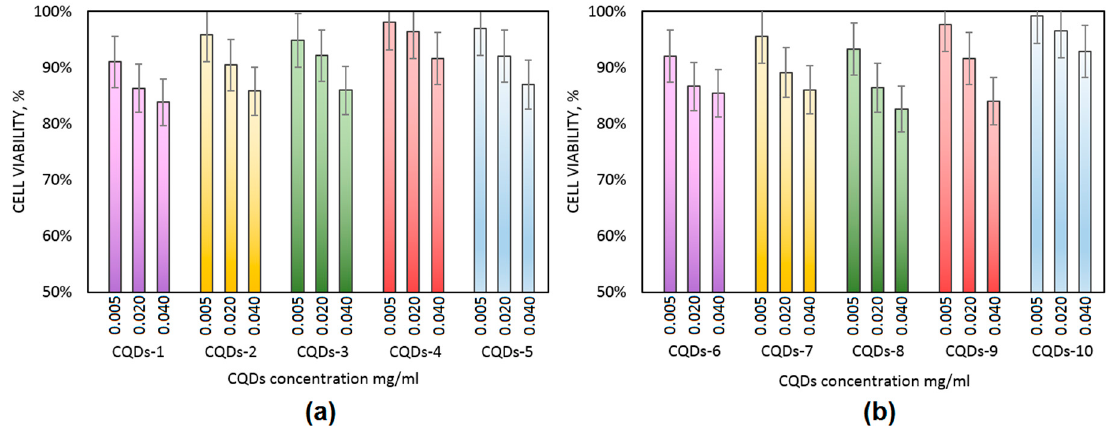
Figure 10. Results of the XTT assay on the prepared CQDs. ( a ) samples CQDs-1–CQDs-5; ( b ) samples CQDs-6–CQDs-10.